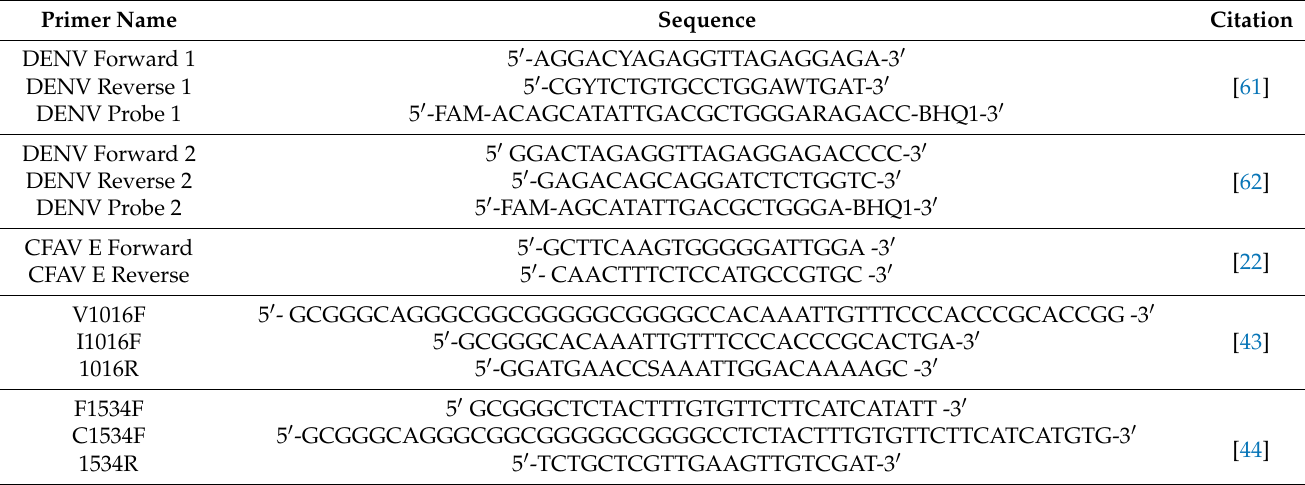
Table A2. Primer and probe sequences for pan-DENV, CFAV, and kdr allele detection in Aedes aegypti .